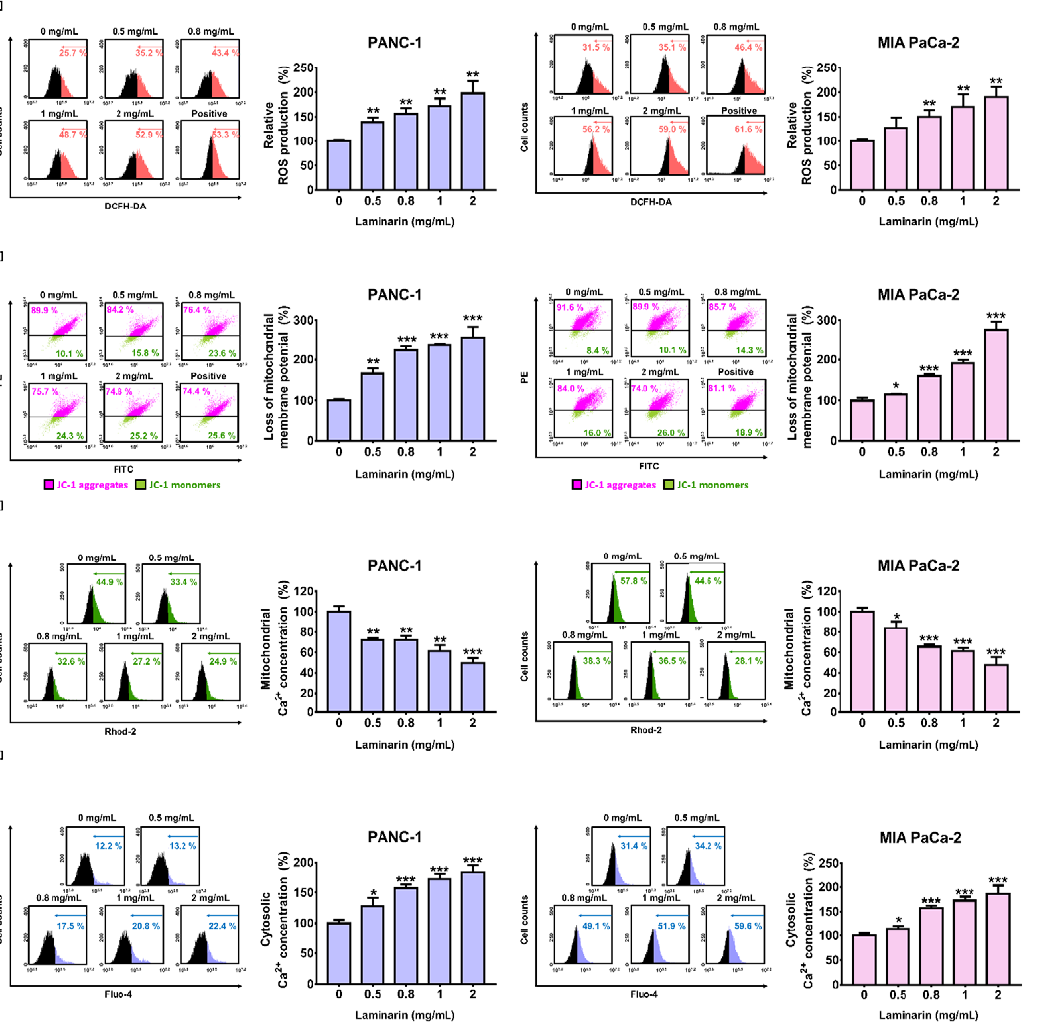
Figure 2. Dose-dependent anticancer effects of laminarin on ROS production, MMP, and calcium homeostasis in PC cells. ( A ) Intracellular ROS evaluated as DCF fluorescence emission by flow cytometry with H 2 O 2 (100 µ M) as the positive control. ( B ) JC-1 monomers in PC cells detected by flow cytometry. Purple and green dots in plot represent JC-1 aggregates and monomers, respectively. Valinomycin (1 µ g/mL) was the positive control. ( C ) Calcium ion concentrations in mitochondria analyzed using Rhod-2. ( D ) Changes in cytosolic calcium concentrations induced by laminarin detected with Fluo-4. (* p < 0.05, ** p < 0.01, *** p < 0.001; laminin vs. control). All experiments were conducted in